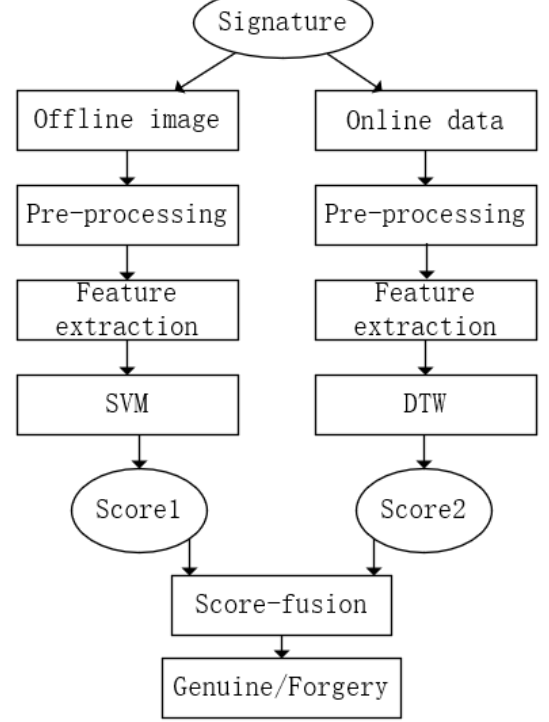
Figure 1. System overview.